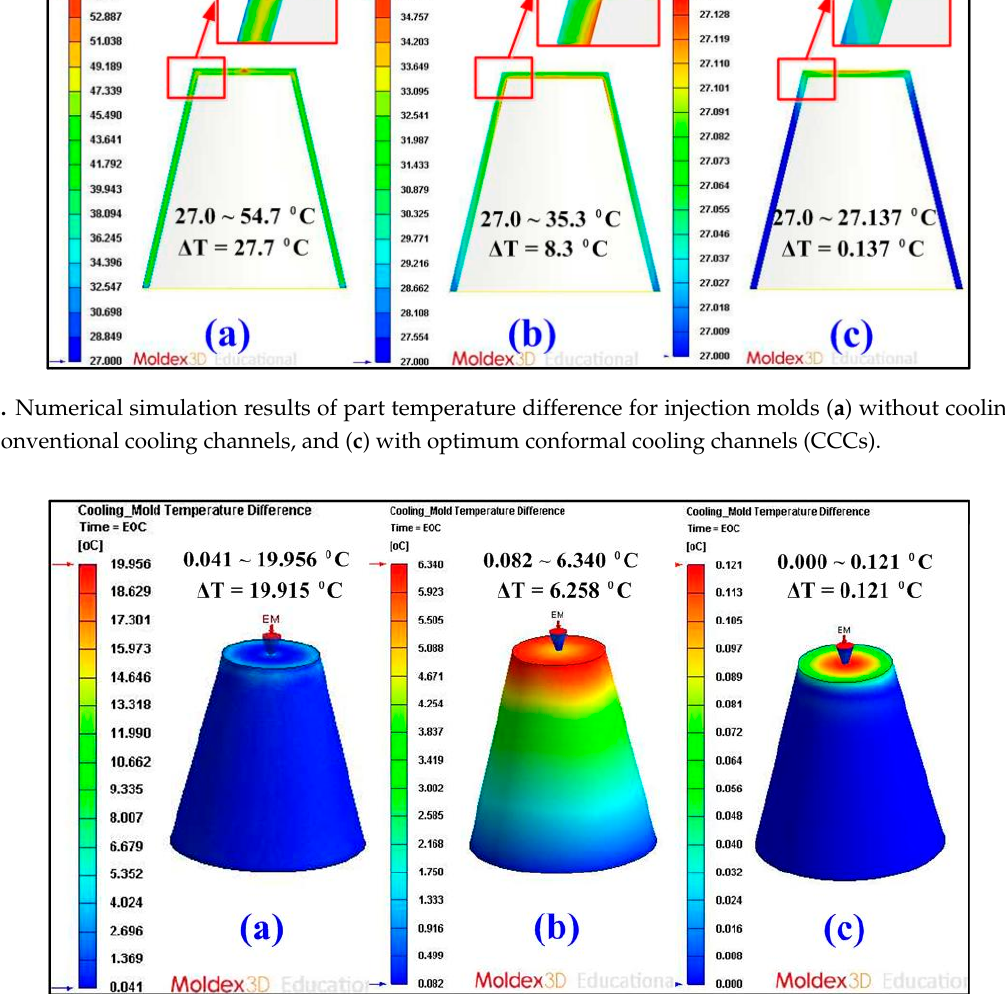
Figure 13. Numerical simulation results of mold surface temperature difference for injection molds ( a ) without cooling channel, ( b ) with conventional cooling channels, and ( c ) with optimum CCCs.